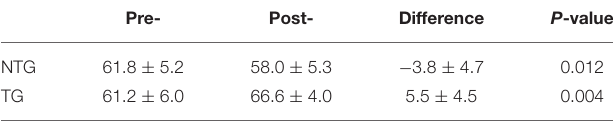
TABLE 1 | Mean and standard deviation of pre- and post-test scores for NTG and TG.